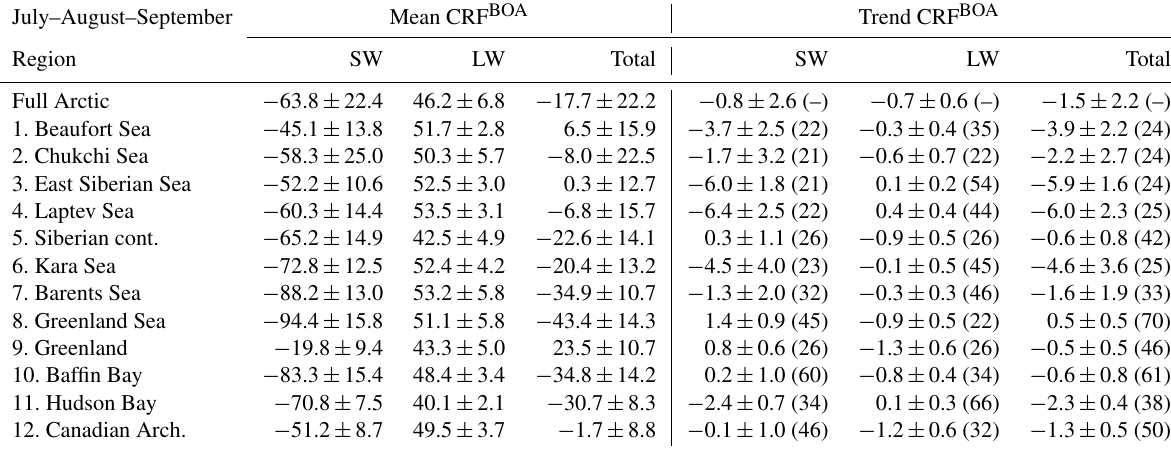
Table 3. As in Table 2 but for Arctic summer (JAS).